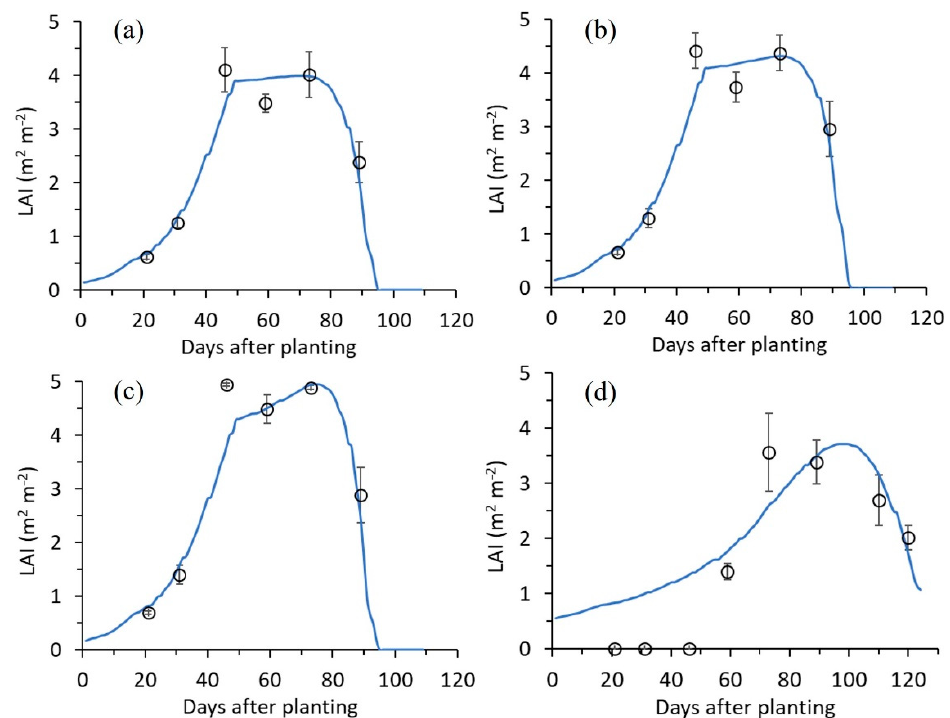
Figure 6. Simulated (Sim) versus observed (Obs) leaf area index (LAI) values of wheat at the Gyeongsang National University field, Jinju, South Gyeongsang Province, Republic of Korea: ( a ) autumn-sown with nitrogen (N) treatments of 40% (40 kg ha − 1 ) at seeding, 30% (30 kg ha − 1 ) at rejuvenation, and 0% (0 kg ha − 1 ) at early reproduction (N40-30-0); ( b ) autumn-sown N40-30-30, ( c ) autumn-sown N40-30-60, and ( d ) spring-sown N40-30-30.